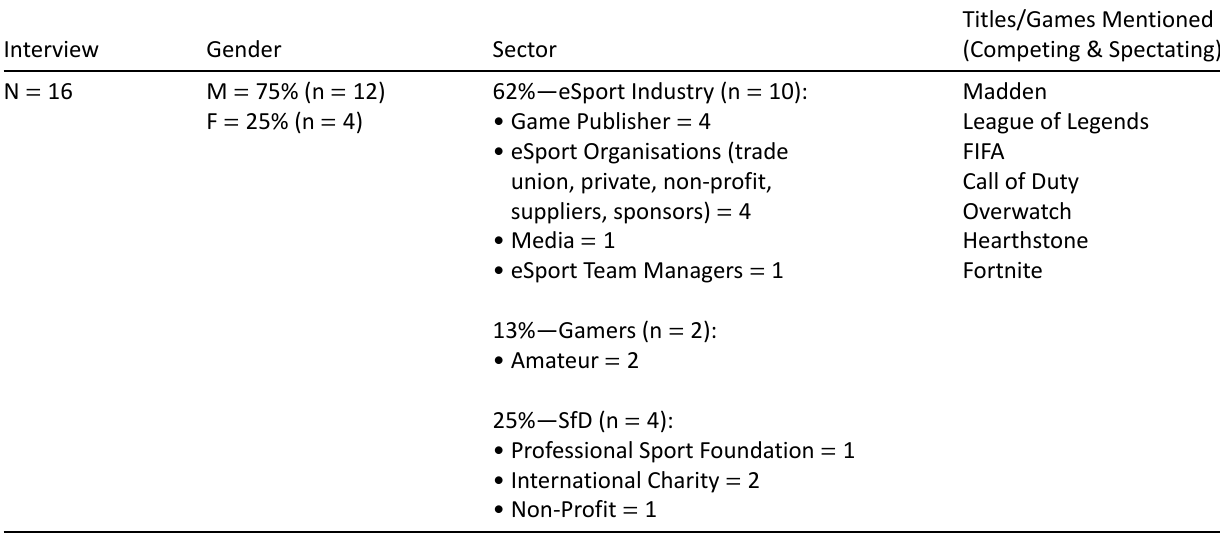
Table 2. Characteristics of interview